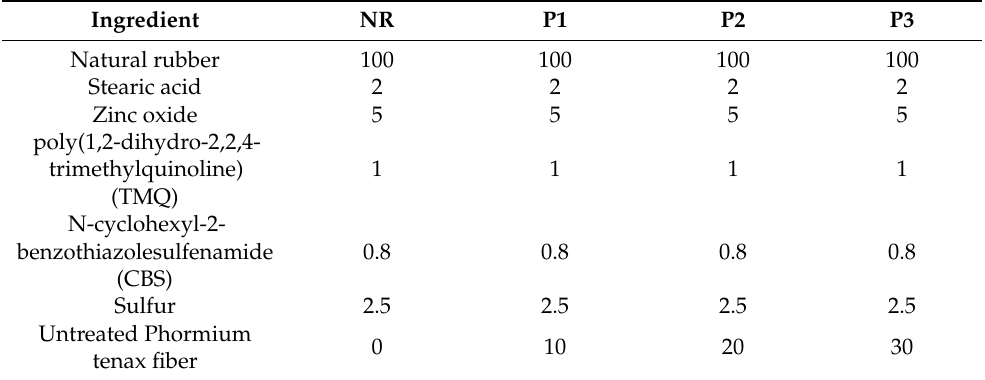
Table 1. Chemicals used for rubber composite production (given per 100 parts natural rubber). Ingredient NR P1 P2 P3 Natural rubber 100 100 100 100 Stearic acid 2 2 2 2 Zinc oxide 5 5 5 5 poly(1,2-dihydro-2,2,4- trimethylquinoline) 1 1 (TMQ)